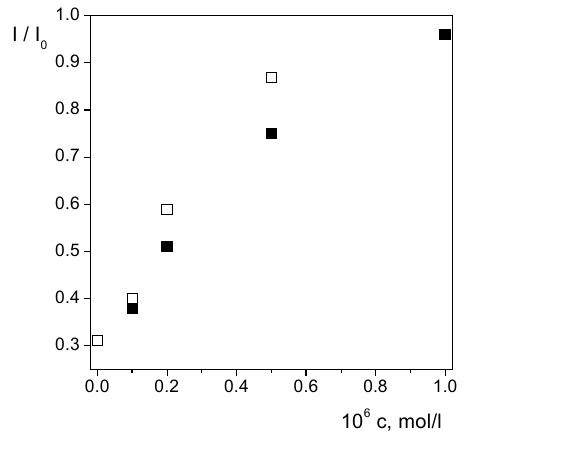
Figure 3. Dependence of the relative Co(phen) cleavage mixture of 5 × 10 -7 mol/l [Cu(phen) O without flavonoid (A), with 5 × 10 -7 mol/l quercetin (B) and 1 × 10 -6 mol/l H 2 2 epigallocatechin gallate (C). DNA/CPE heated to 20 °C ( (cid:1) , (cid:1) ), 27 °C ( (cid:2) , (cid:2) ) and 38 °C ( (cid:1) , (cid:2) ). Other conditions as in Figure 2.